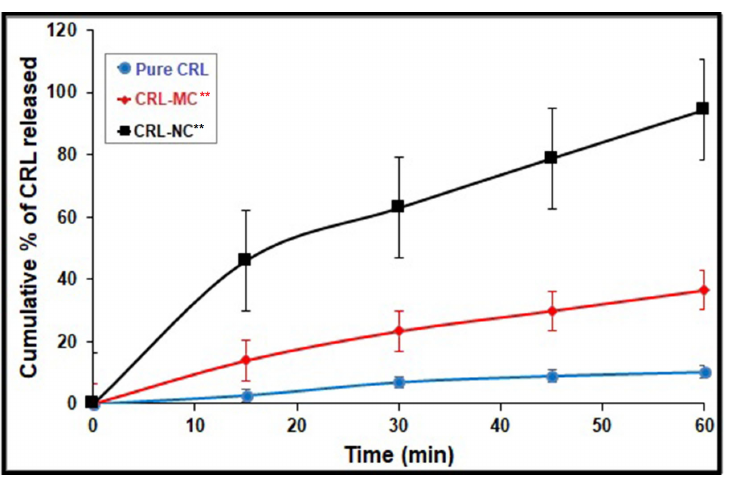
Figure 8. In vitro dissolution of pure CRL, CRL-MC, and -NCs (mean ± SD, n = 3); the significant differences related to control (pure CRL) are represented by ** p < 0.05 evaluated by the ANOVA test.